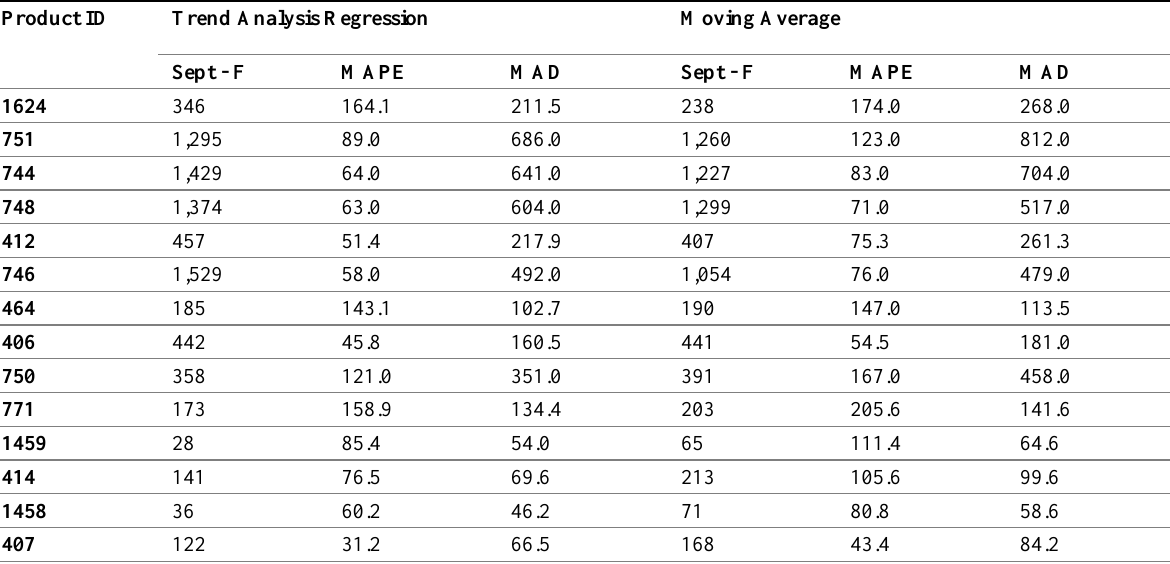
Table 2: September Demand Forecasting Result – Trend Analysis and Moving Average